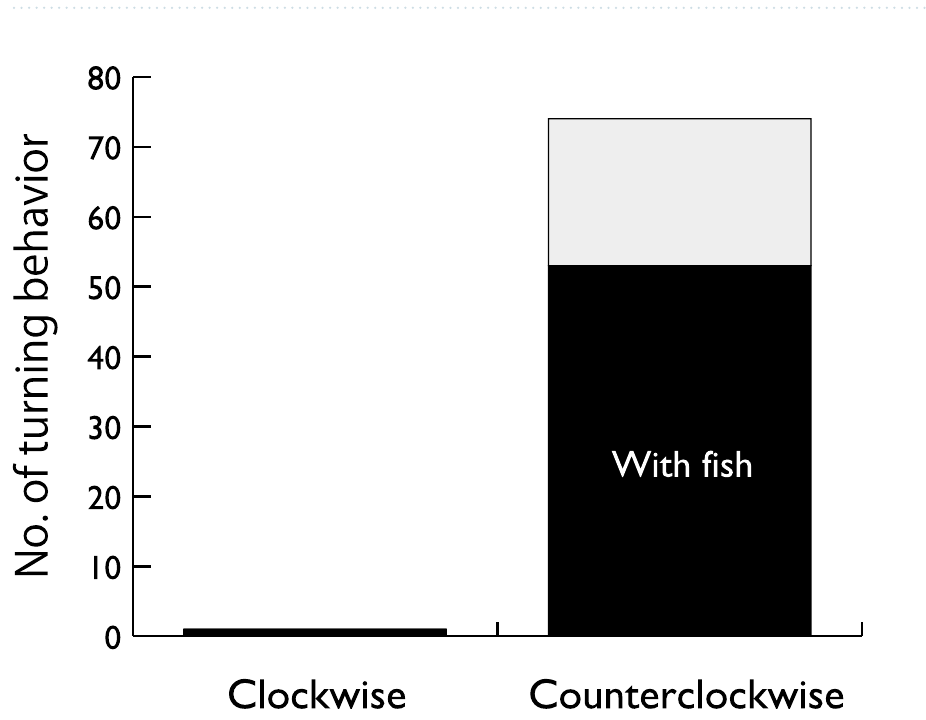
Figure 2. Numbers of clockwise and counterclockwise turning behaviors in finless porpoises noted during land-based observations. Black bars represent cases where a fish or a school of fish was observed ahead of the